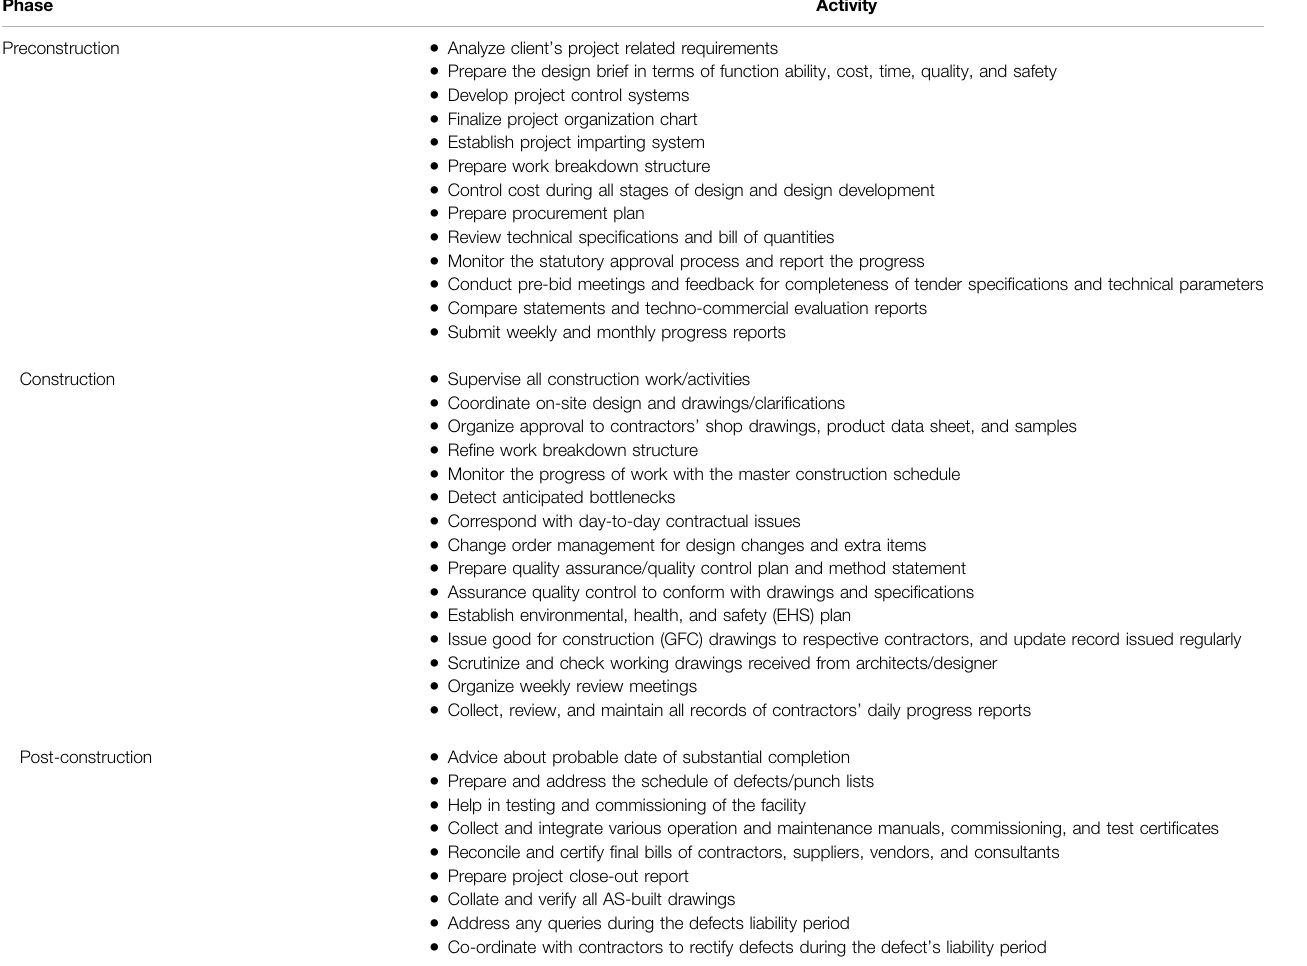
TABLE 1 | Main activities in each phase of construction projects (Nikumbh and Pimplikar